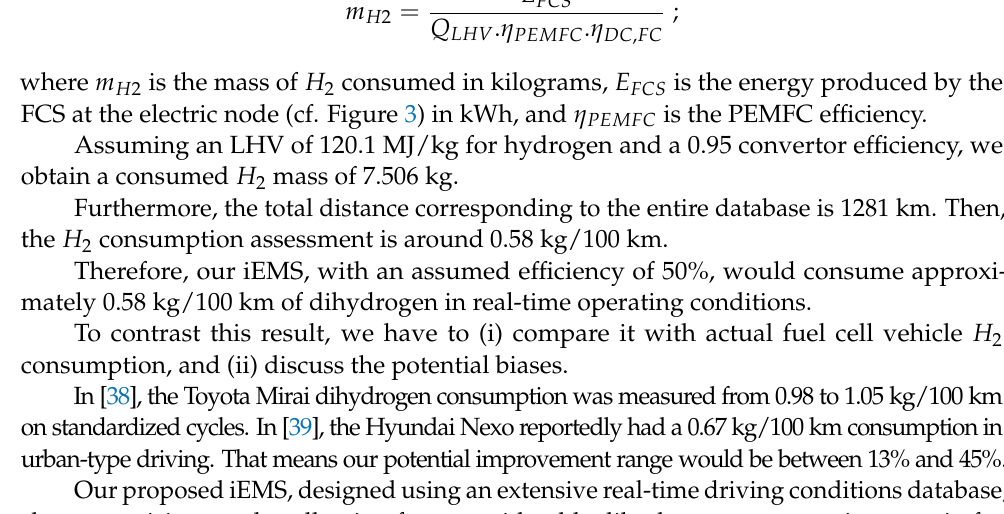
Figure 14. ( a ) iEMS results on a selected window; ( b ) iEMS compared with the optimal offline PMP.